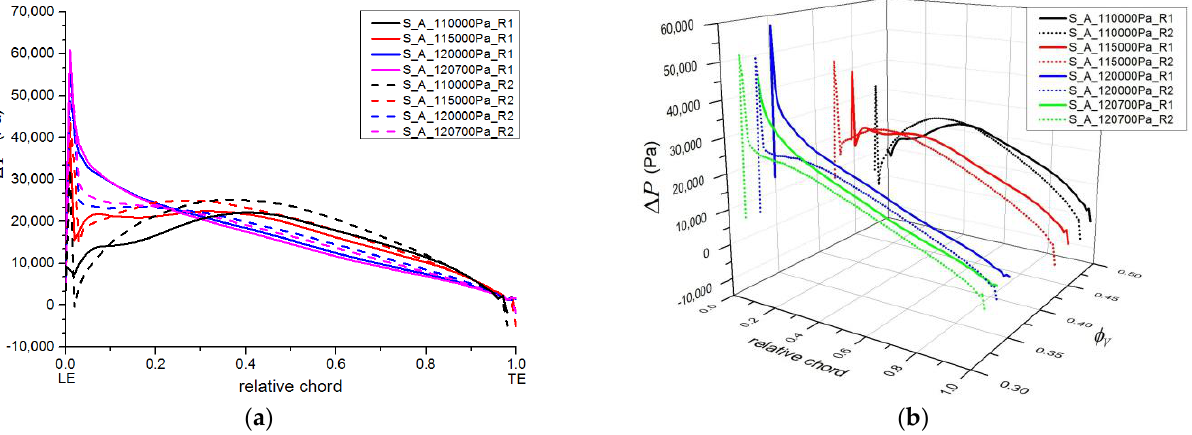
Figure 8. Load curve of blade-tip region in the S_A model. ( a ) Blade load vs. relative chord and ( b ) blade load vs. relative chord and volume flow.